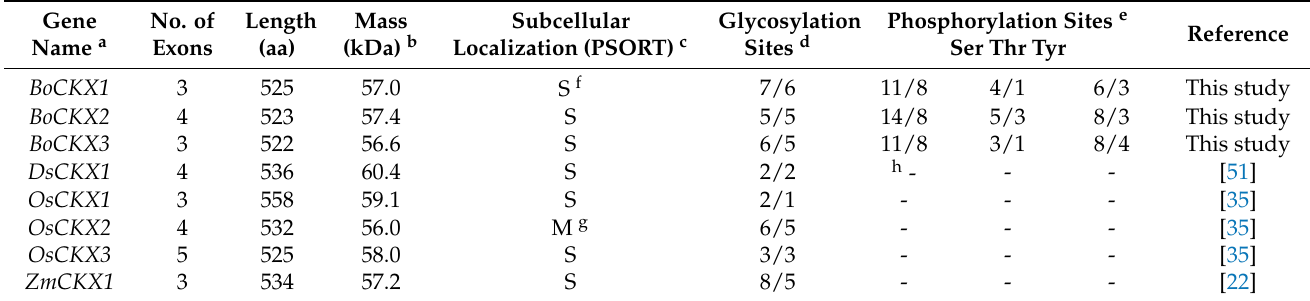
Table 2. Features of different CKX proteins from various plants.